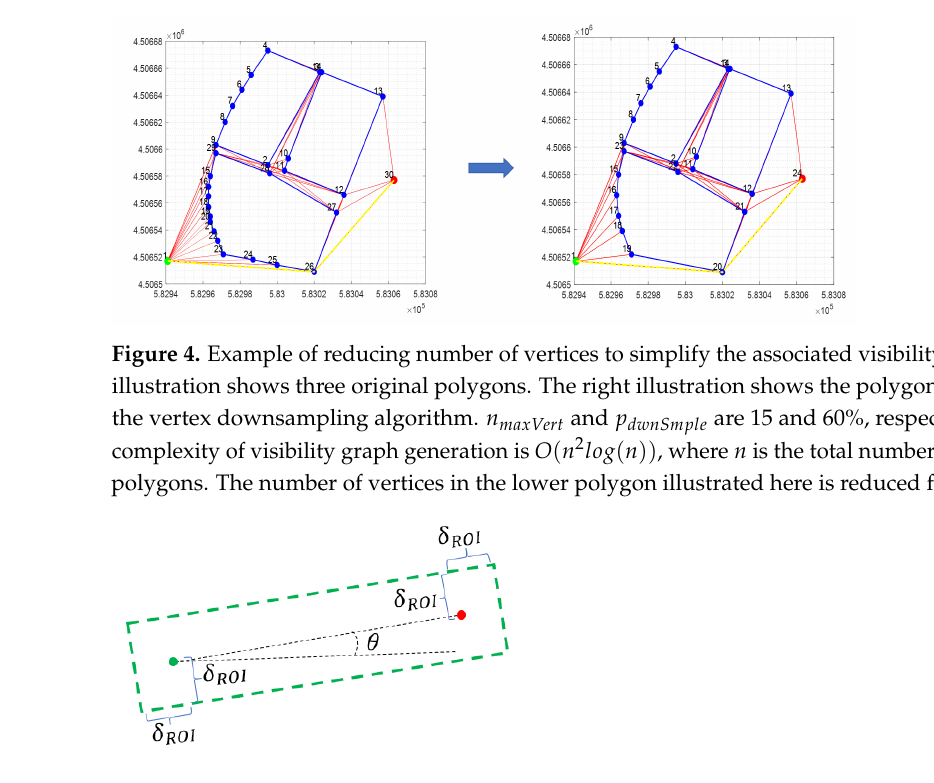
Figure 5. Illustration of rectangular ROI generation. Start point, destination point, and ROI initial buffer size δ ROI are used to initialize the rectangular ROI per Algorithm